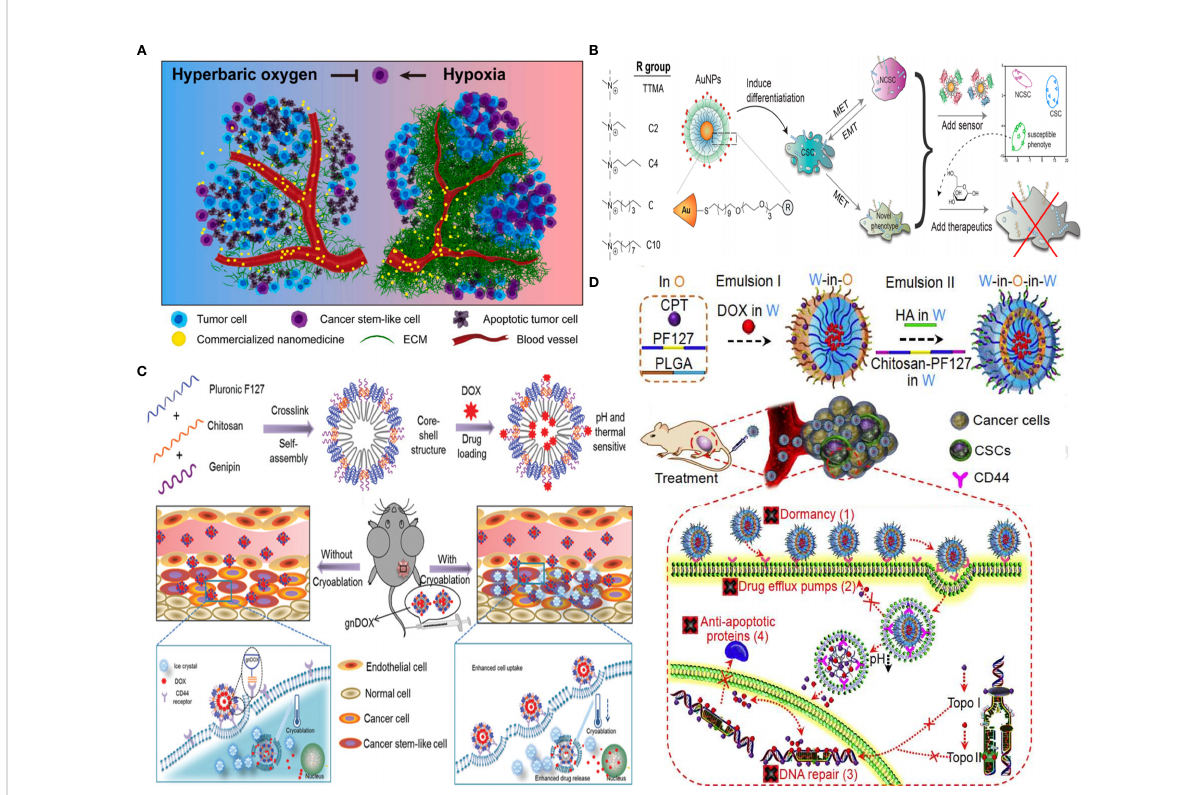
FIGURE 9 Strategies for CSC targeting and elimination. (A) Hyperbaric oxygen therapy. Reprinted with permission from (92), Copyright (2021) Elsevier. (B) NP surface modi fi cation from hydrophilic (TTMA) to highly hydrophobic (C10) tested, with C6 AuNP robustly promoted CSC differentiation by reducing stemness marker. Reprinted with permission from (128), Copyright (2020) American Chemical Society. (C) Multimodal system combines chemo- and cryoablation therapy. Reprinted with permission from (129), Copyright (2021) Elsevier. (D) Receptor-mediated dual drug combination strategy. Reprinted with permission from (130), Copyright (2021) Royal Society of